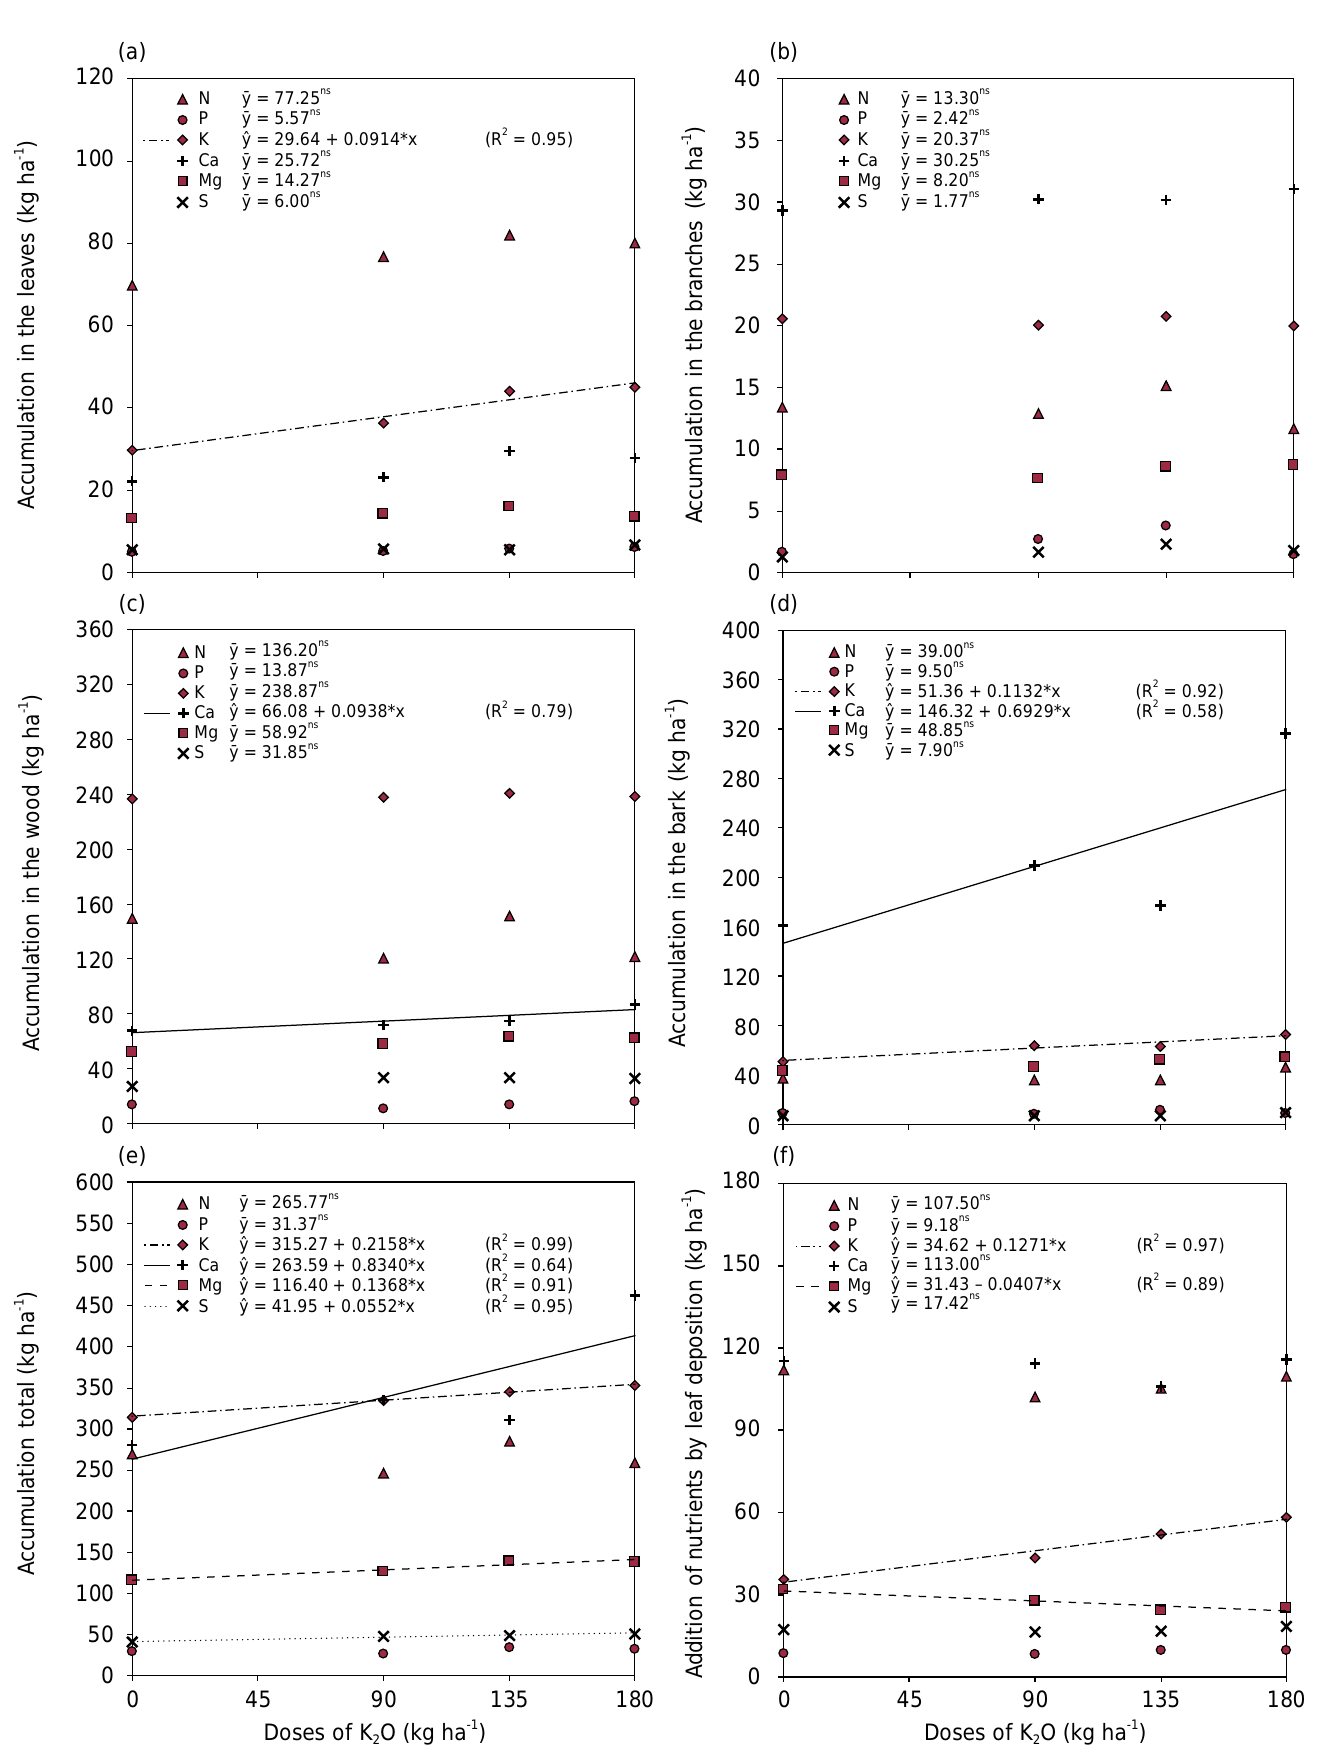
Figure 4. Accumulation of nitrogen, phosphorus, potassium, calcium, magnesium, and sulfur in the different compartments of Eucalyptus plants (leaves, branches, wood, bark, and total, respectively, a, b, c, d, and e) and addition of nutrients by leaf deposition (f), as a function of doses of K 2